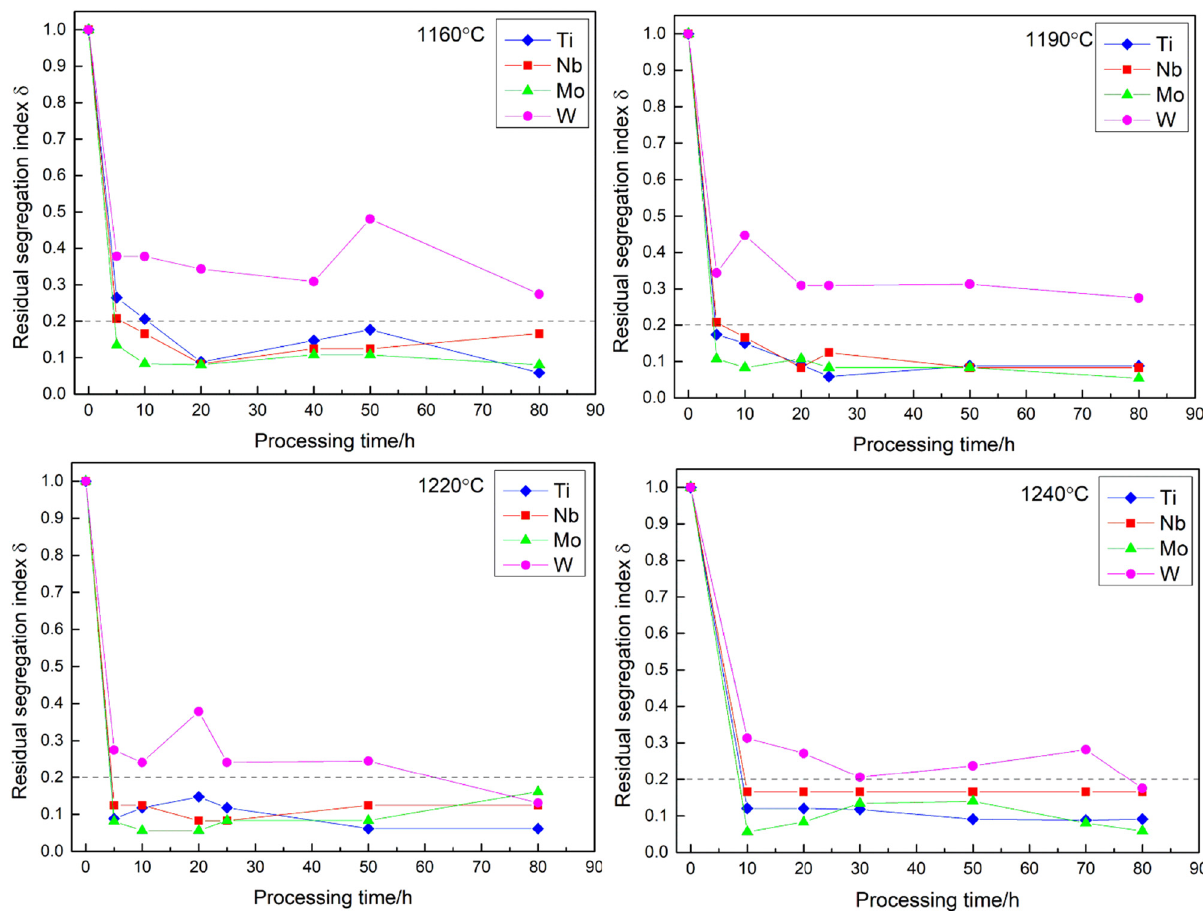
Figure 9: Residual segregation index evolution of samples from Disk I at a variety of homogenization